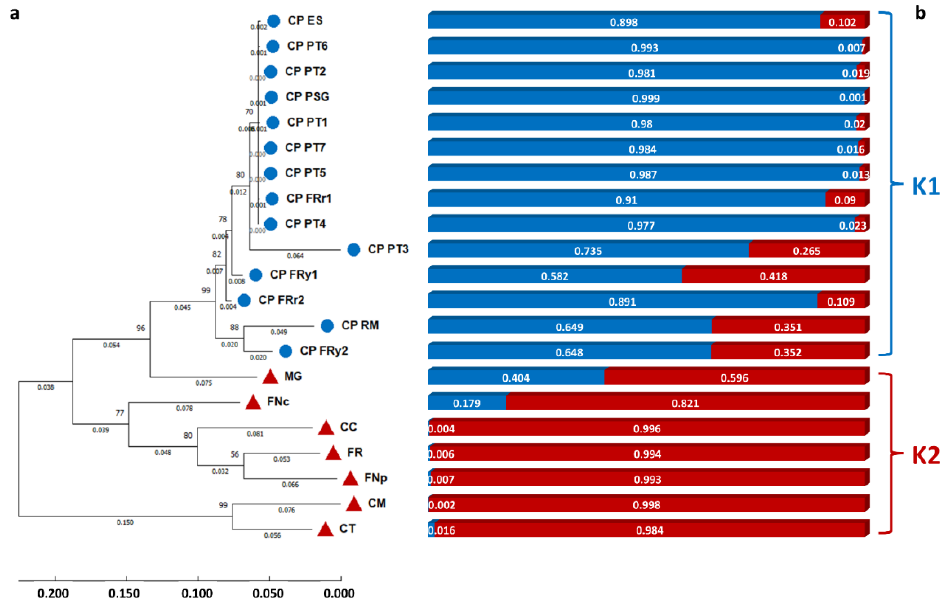
Figure 6. Phylogenetic analysis and population structure of 21 pepper accessions based on 2196 SNPs. ( a ) Maximum likelihood composite phylogenetic tree using the Tamura–Nei model; numbers at the nodes are bootstrap values for 1000 resamplings. ( b ) STRUCTURE analysis considering K = 2 clusters on the basis of Evanno’s test. Horizontal solid bars for each genotype represent the allele frequency (indicated with numbers) for each K.